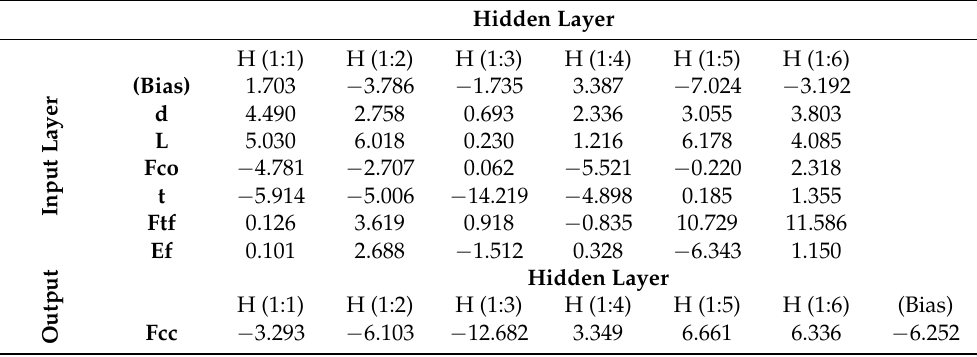
Table 5. Matrix of weights for ANN — GA